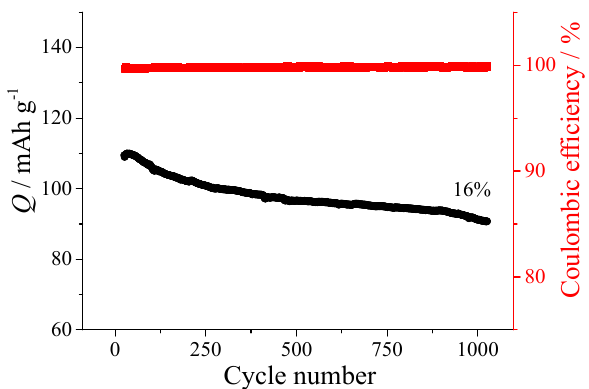
Figure 9. Cycling performance and Coulombic efficiency for the LFMP PEDOT:PSS/CMC cathode vs. LTO PEDOT:PSS/CMC anode at 1 C (based on our data in Ref. [64]).